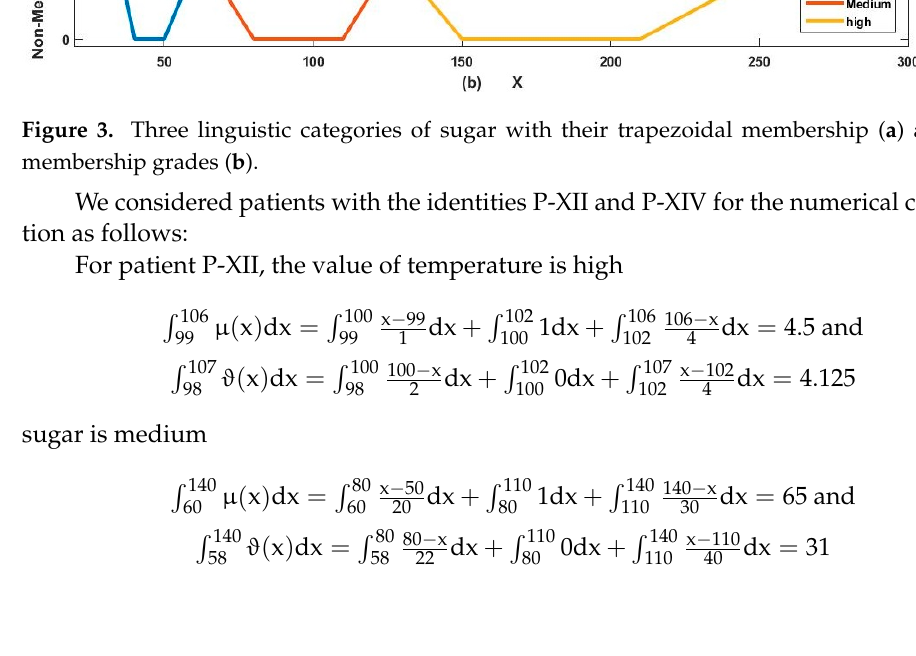
Figure 4. Three linguistic categories of pulse rate with their trapezoidal membership ( a ) and non-membership grades ( b ). Figure 5. Three linguistic categories of age with their triangular membership ( a ) and non-membership grades ( b ).